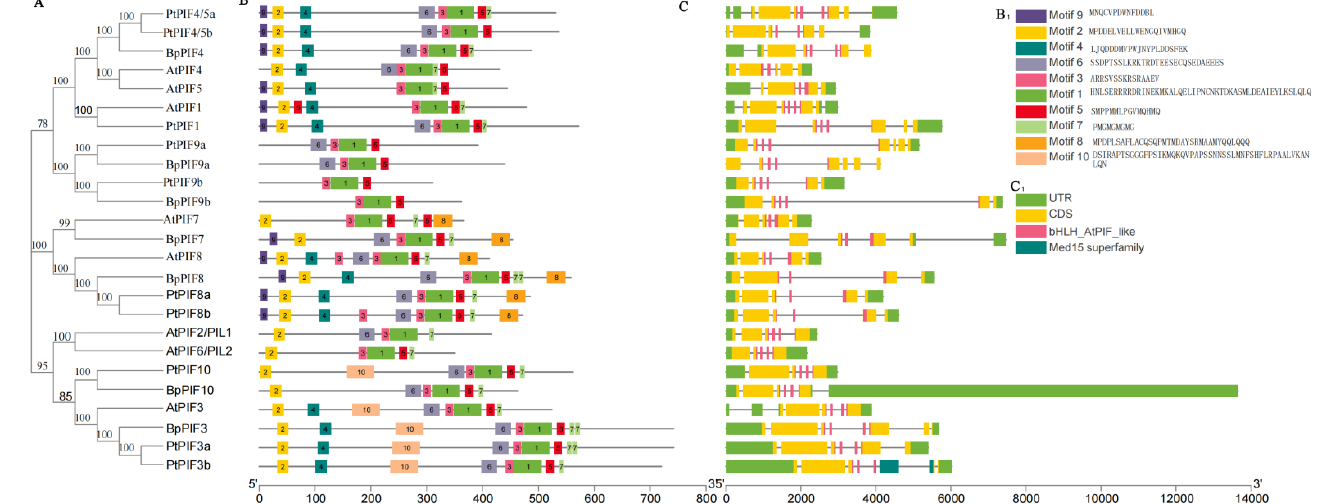
Figure 2. Phylogenetic relationships, conserved protein motifs, and gene structure in PIF genes from Betula platyphylla Suk. ( A ) The phylogenetic tree of Betula platyphylla Suk., Arabidopsis thaliana, and Populus trichocarpa PIFs were exhibited. ( B ) The motif composition of BpPIF proteins. The motifs are displayed in different coloured boxes. B 1 is the legend of Figure B ( C ) The exon–intron structure of BpPIF genes. Exons and UTRs are represented as dark yellow and green boxes, respectively, while black lines indicate introns. Pink boxes highlight the bHLH-AtPIF-like domain. C 1 is the legend of figure C